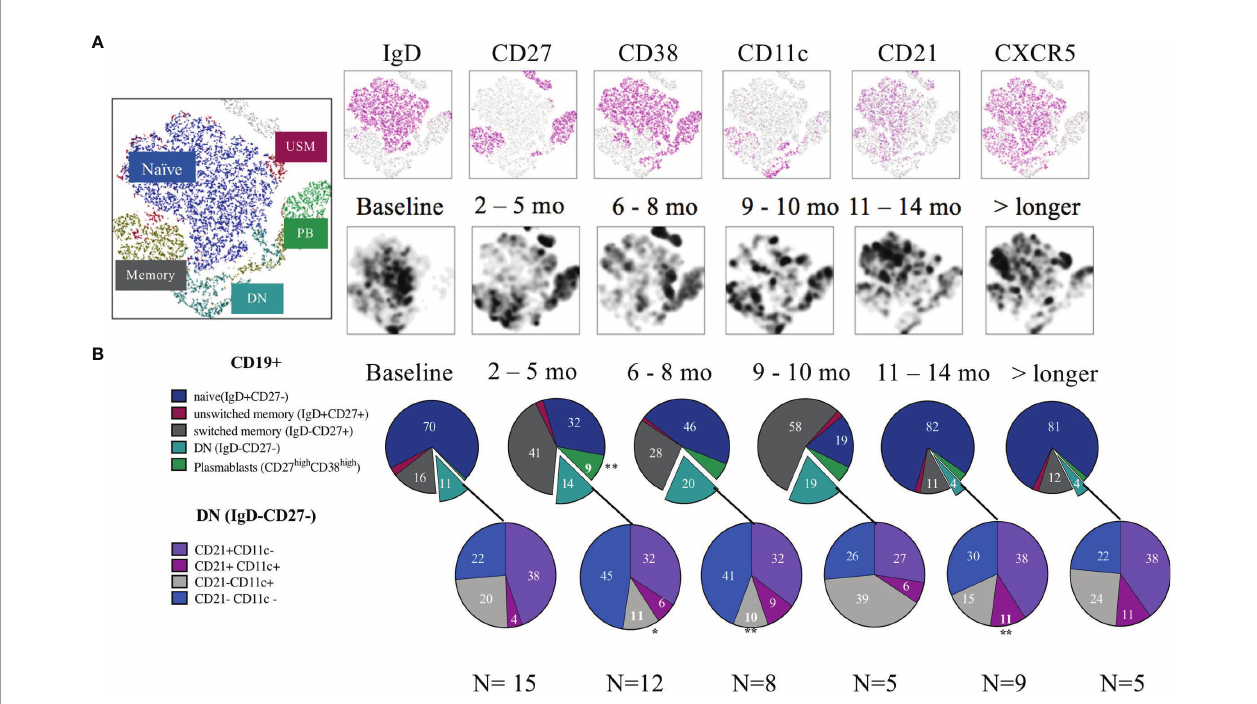
FIGURE 2 | B cell subsets after rituximab treatment. (A) tSNE from CD19+ cells over time. The upper row shows the different markers distributed in the tSNE while the second row illustrates the density of cells in the different timelines. (B) Pie charts of the frequency (median) from each subset. First cells were gated for live CD19+ B cells, then for Plasmablasts (CD38++/CD27++), the rest of the cells were gated using a quadrant gate for CD27+ and IgD to identify naïve, unswitched memory, memory and double negative cells. The negative cells were further divided using the markers CD21 and CD11c. Signi fi cant change from the baseline are indicated with an